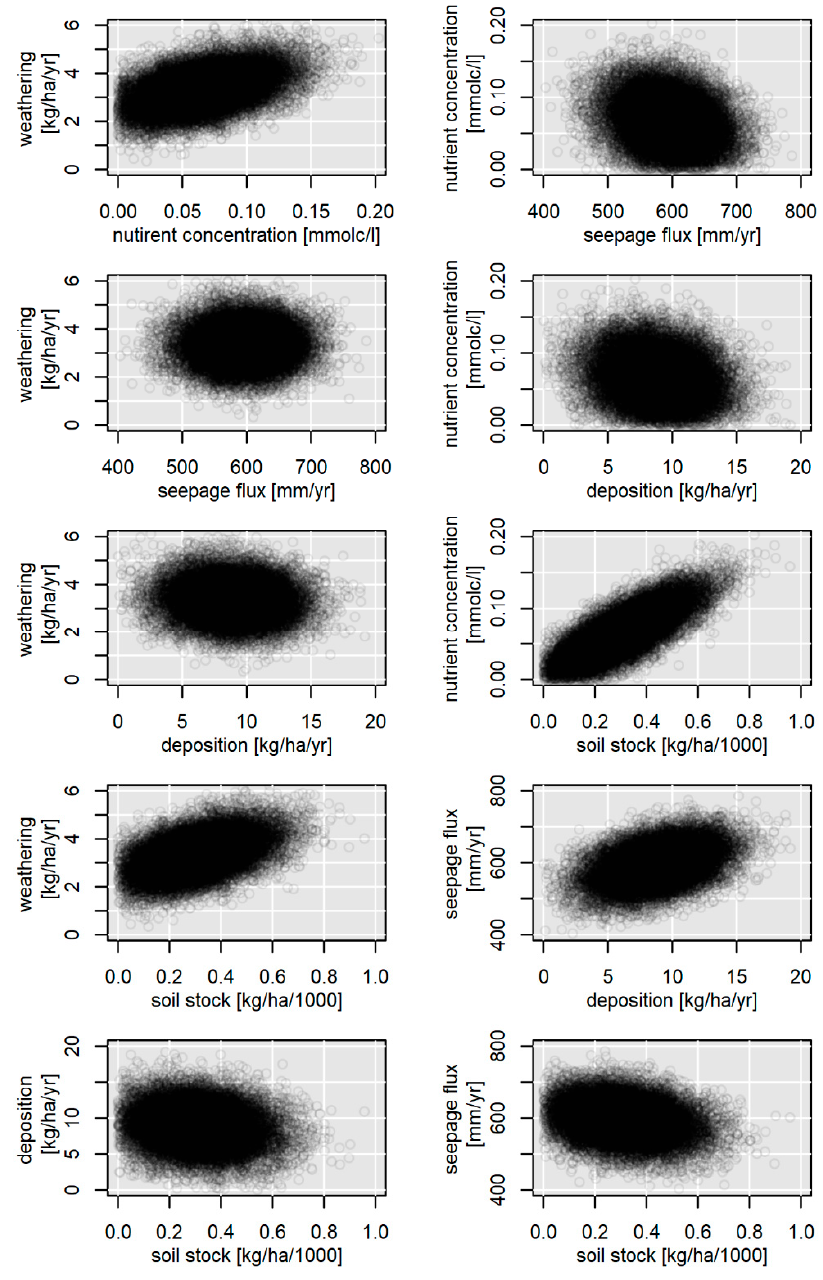
Figure A4. Example for randomly varied input data of the calcium (Ca) balance considering the covariance in the Monte Carlo procedure for the NFSI plot with the ID 30016. covariance in the Monte Carlo procedure for the NFSI plot with the ID